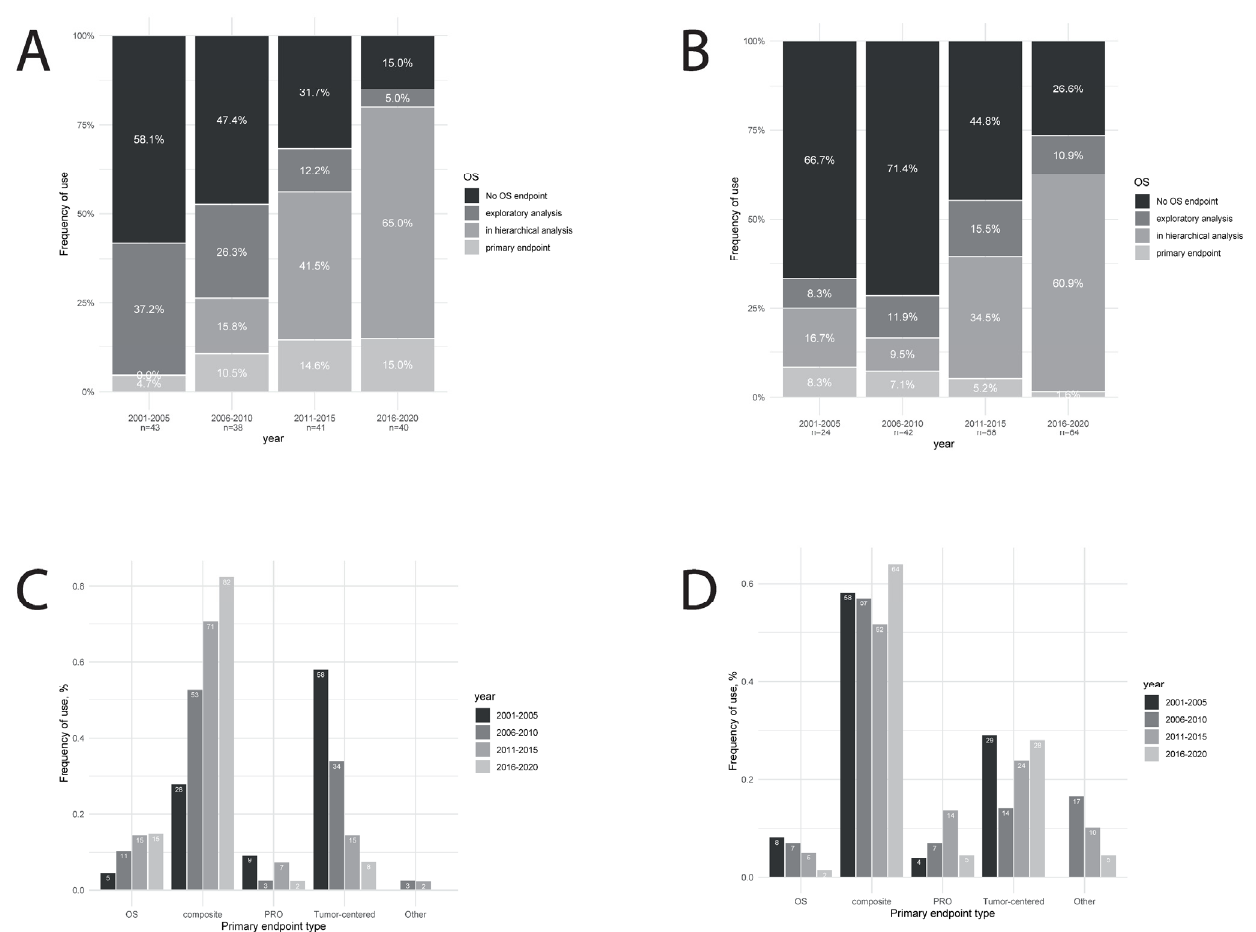
Figure 2. Use of overall survival over time in ( A ) metastatic or advanced breast cancer trials and ( B ) early-stage breast cancer trials. Type of primary endpoints used in ( C ) metastatic or advanced breast cancer trials and ( D ) early-stage breast cancer trials. Footnotes: OS = overall survival; PRO = patient-reported outcomes.